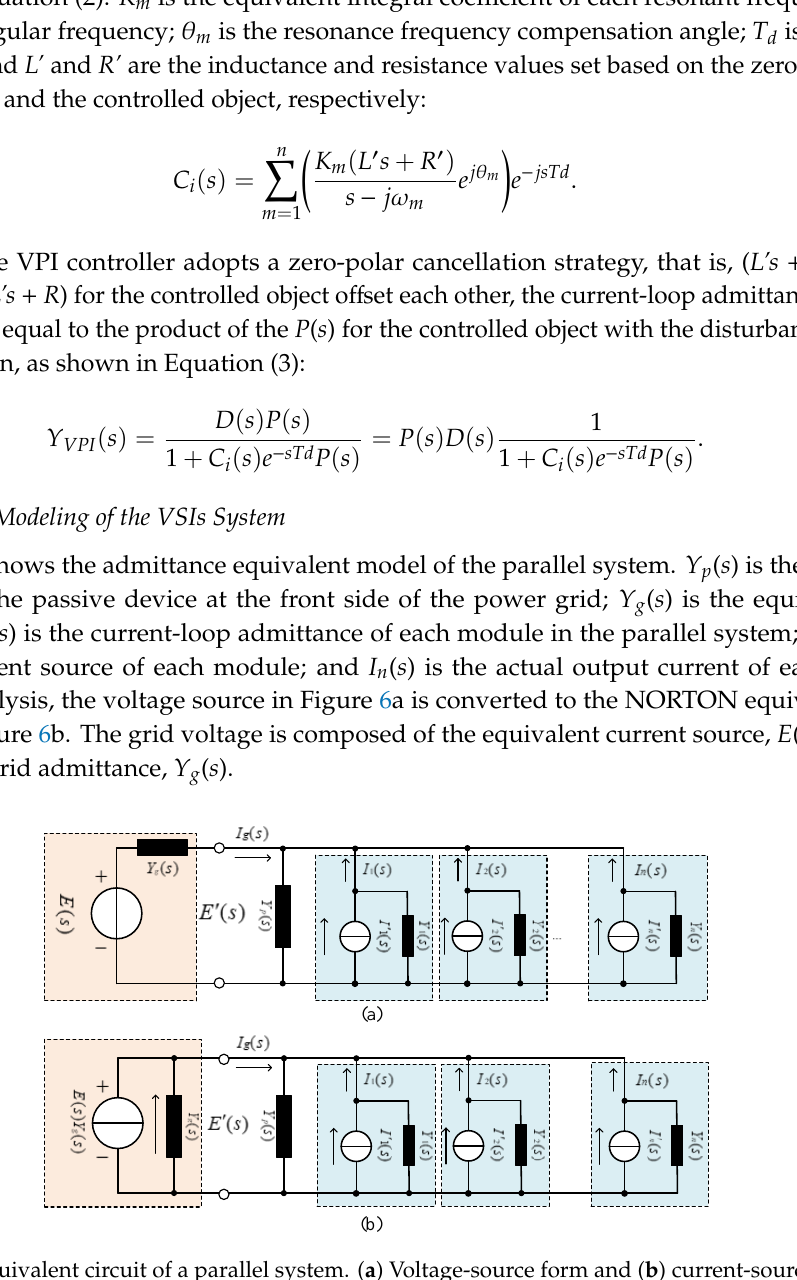
Figure 6. Equivalent circuit of a parallel system. ( a ) Voltage-source form and ( b ) current-source form.